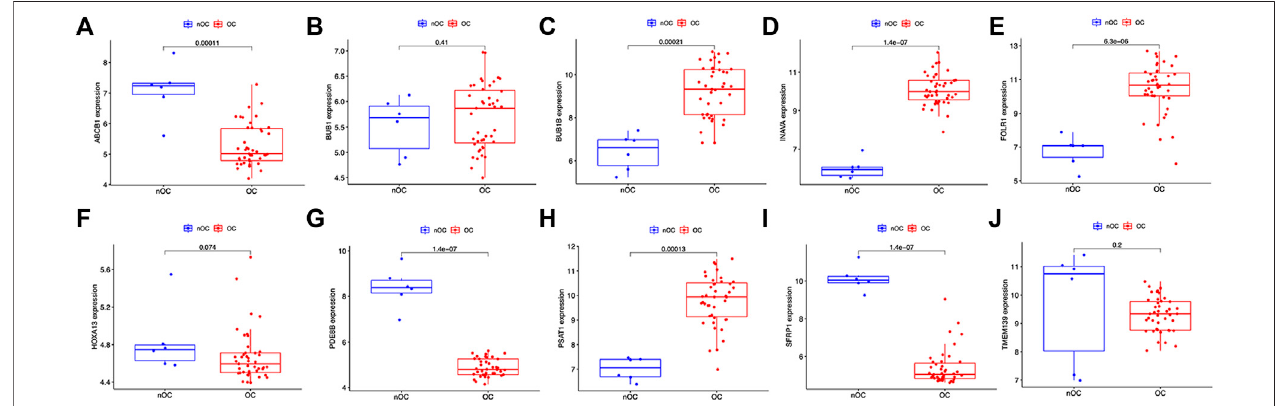
FIGURE5| CharacteristicgenesbetweentheOCgroupandthenOCgroupinthetrainingset. (A-J) Theboxplotshowstheexpressionoftheintersectiongenesin the trainingset betweentheOCgroup and thenOCgroup. Red indicates theovarian cancergroup, and blue indicates thenon-ovariancancergroup. p < 0.05indicates differential expression.